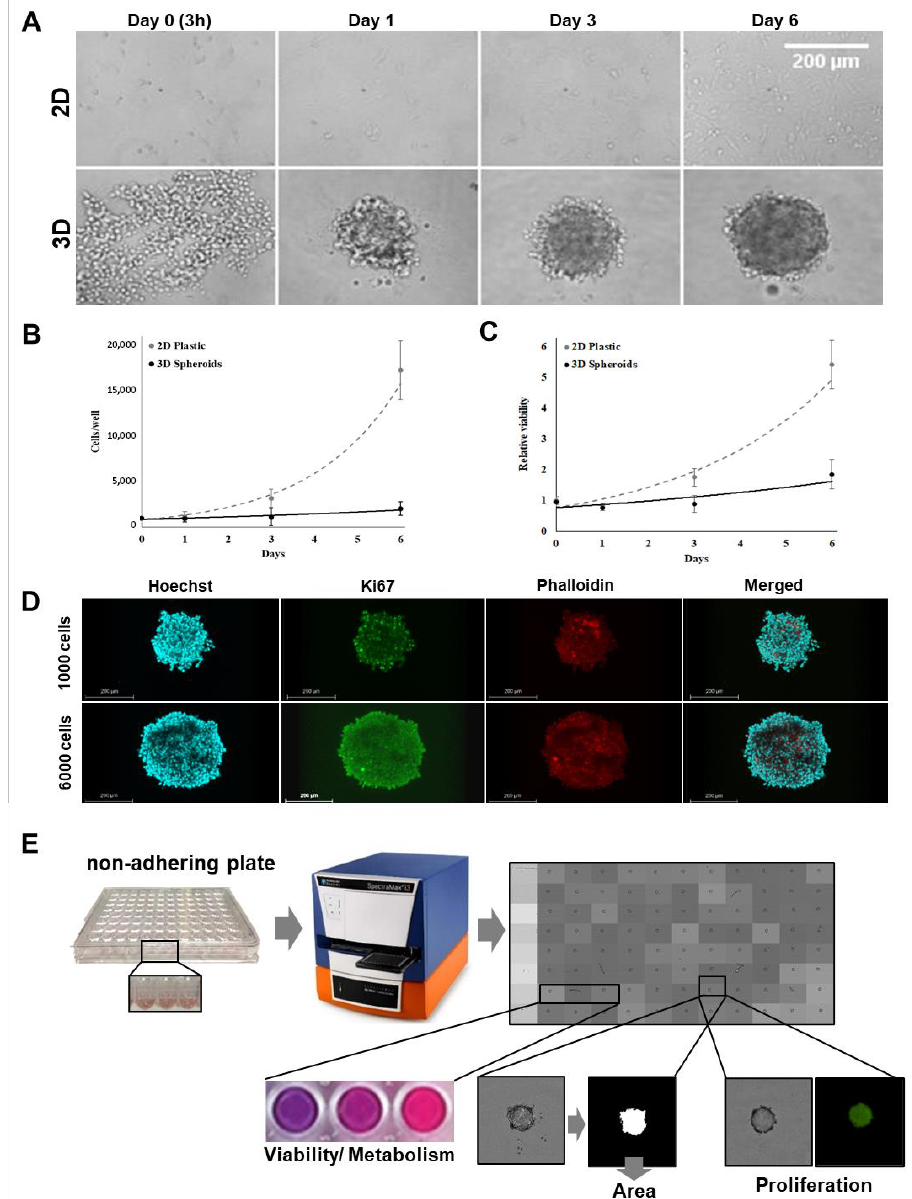
Figure 1. Growth kinetics of MCM DLN human melanoma cells in 2D and 3D cultures. ( A ) One thousand cells were seeded to generate 2D cultures (adherent plastic plates) and 3D spheroids (non-adherent plates), and cell growth was detected by phase-contrast microscopy on day 0 (3 h after seeding), 1, 3, and 6 using a Leica DMI6000B inverted microscope. ( B ) On days 1, 3, and 6, cells were harvested by trypsinization to determine the cell number. ( C ) Cell viability measurements were conducted using Presto blue, normalized to the viability of day 0 (3 h after seeding). Each data point represents the mean ± standard deviation (S.D.) of six independent experiments. ( D ) One thousand or 6000 MCM DLN cells were cultured as three-dimensional (3D) cell aggregates using non-adherent plates. After 4 days, the spheroids were fixed, permeabilized, and stained with antibodies for the proliferation marker, Ki-67, Hoechst, and phalloidin. Images were acquired using a Leica TCS SP8 confocal laser scanning microscope. It should be noted that Ki-67 positive cells in the spheroids seeded with 1000 cells are found to be evenly distributed and, in the larger spheroids (6000 cells), only in the outer rim. Scale bars: 200 µ m; Z-stack: Supplementary Videos S2 and S4. ( E ) Schematic presentation of the high content phenotypic drug screening assay